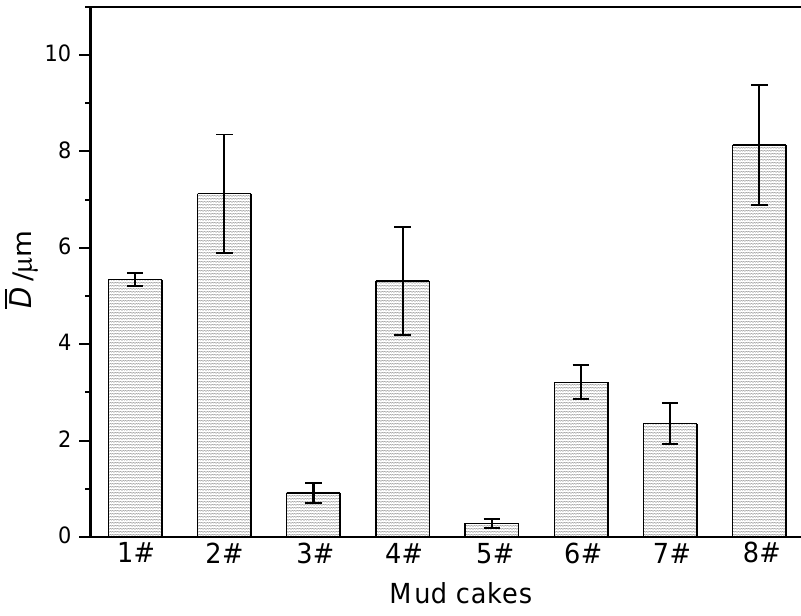
Figure 11. The average pore diameters of the surfaces of mud cakes.